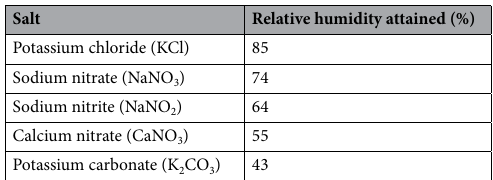
Table 1. Saturated salt solutions used to achieve relative